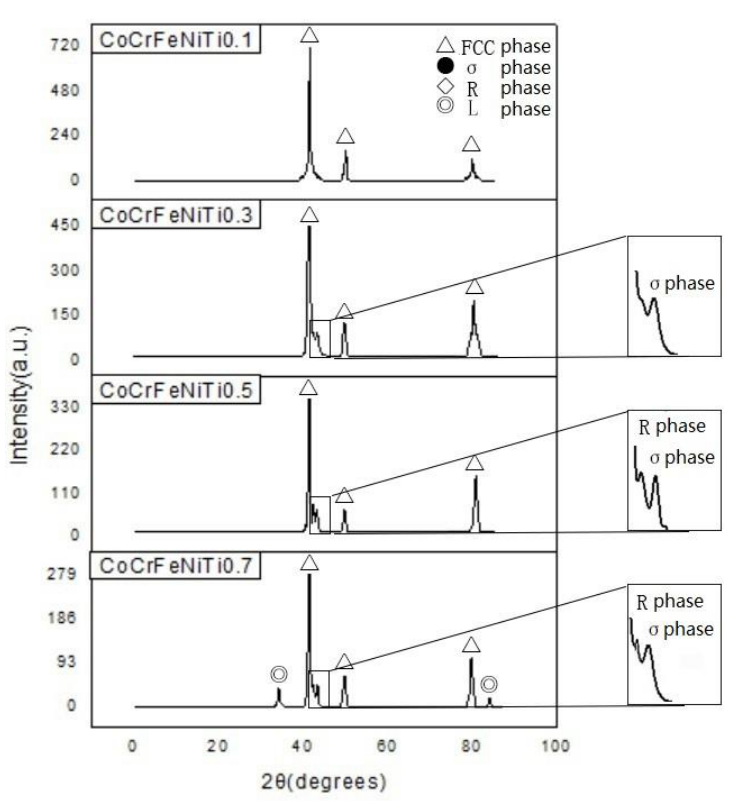
Figure 4. X-ray di ff raction (XRD) spectra of CoCrFeNiTi x HEA Figure 4. X-ray diffraction (XRD) spectra of CoCrFeNiTi x HEA coatings.